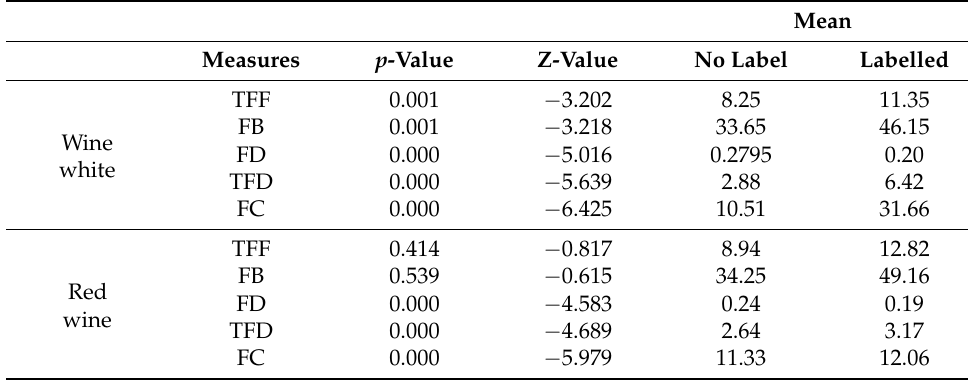
Table 2. Attention to individual bottle ads without label (vs. with